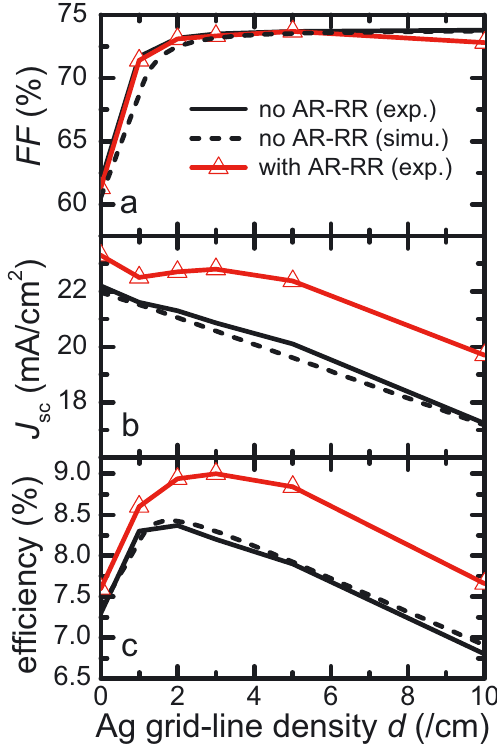
Fig. 3. Experimental and calculated parameters of µ c-Si:H solar cells deposited on thermally treated front ZnO:Al lay- ers fitted with Ag fingers of varying density. The curves with triangles represent parameters of cells with an antireflec- tive/retroreflective (AR-RR) foil. Note that finger densities d of 0 < d < 1 make sense only for the simulated data since the experimental parameters extracted here were measured on cells with an active area of 1 × 1 cm 2 . The case d = 0 represents the cell with no Ag